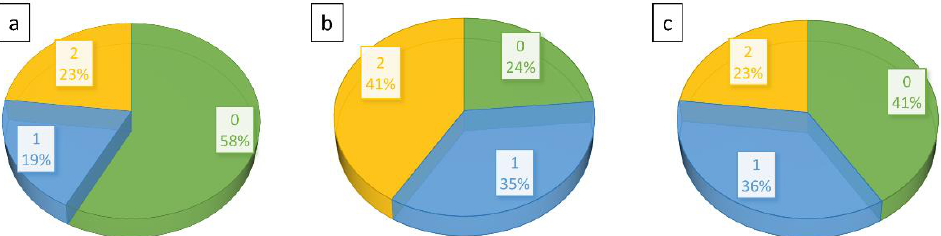
Figure 8. Diagrams illustrating percentage distribution of skeletal maturity measured with Risser grade (0 to 5) in the study cohort. ( a ) — deterioration group, ( b ) — unchanged, and ( c ) — improvement group.